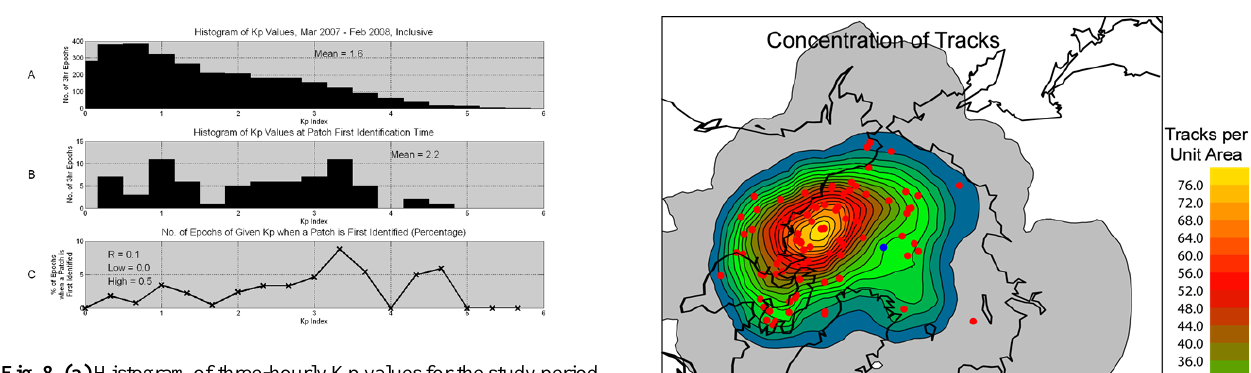
Fig. 8. (a) Histogram of three-hourly Kp values for the study period. Note that Kp never reaches 6. (b) Histogram of Kp values at times when TRACK first identifies a patch. (c) Kp value at times when TRACK first identifies a patch vs. percentage of identified patches when that Kp value prevailed. No linear correlation exists between Kp and times when TRACK first identifies a patch.